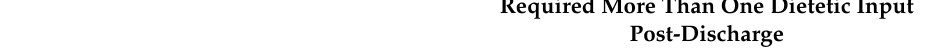
Table 5. Multivariable logistic regression for patients who required more than one dietetic input after hospital